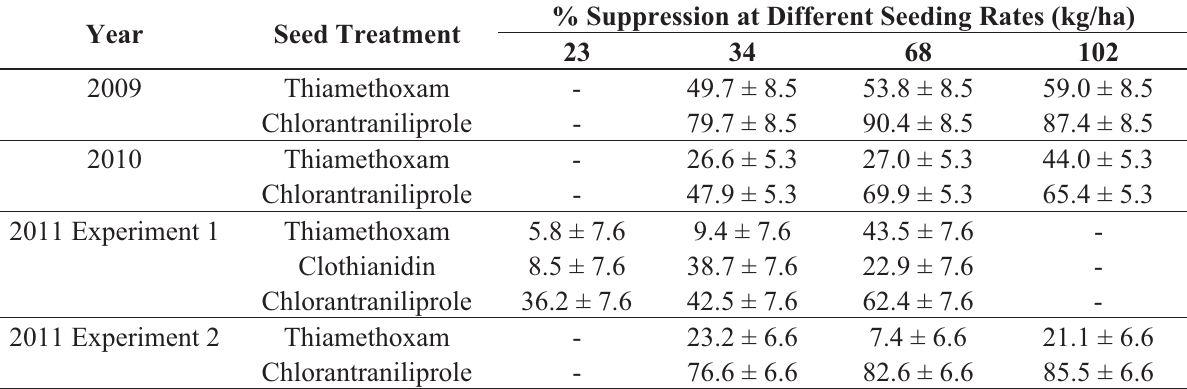
Table 3. Percent suppression of immature weevils by rice seed treatments under different seeding rates in small-plot experiments during 2009–2011 a